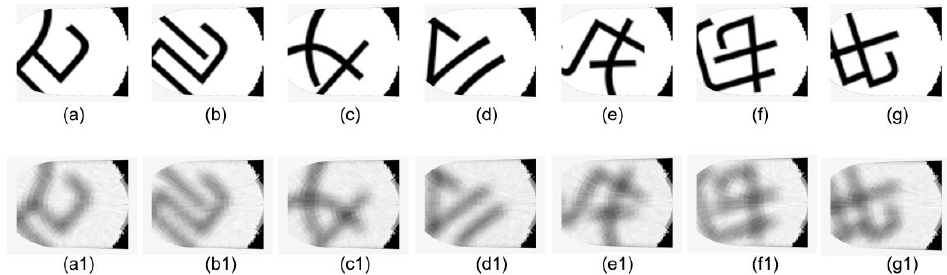
Figure 7. Examples of training image pairs of the training set. ( a – g ) are the standard images; ( a1 – g1 ) are the distorted images of ( a – g ),